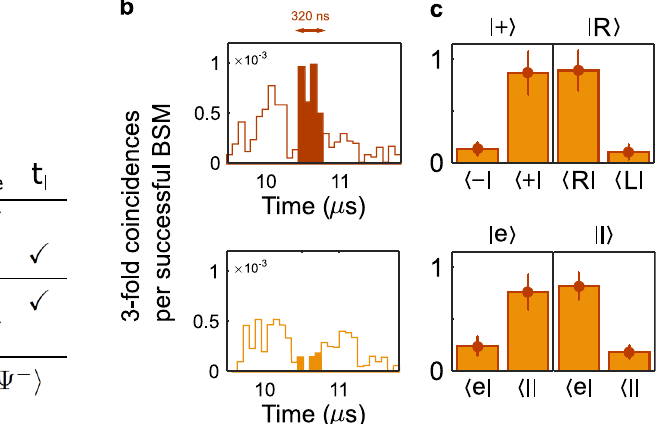
Fig. 2 | Short distance quantum teleportation. a Schematic of the working central one corresponds to a projection in the superposition basis. c Normalised coincidences for different input qubits using a parallel and orthogonal setting of principle of the time-bin Bell-state measurement. Consecutive clicks at any detec- (cid:1) the analyser. The two upper plots correspond to the equator measurements and tor project the input qubit-idler qubit joint state into ∣ Ψ + , while alternate detec- the two lower plots correspond to the measurements of the poles. The error bars tions project it into ∣ Ψ (cid:2) i . b 3-fold coincidence histograms after parallel and correspond to±1 σ . orthogonal analysers, renormalised to the total amount of successful BSMs for an input state ∣ R i . Three coincidence peaks appear in the analysis where only the